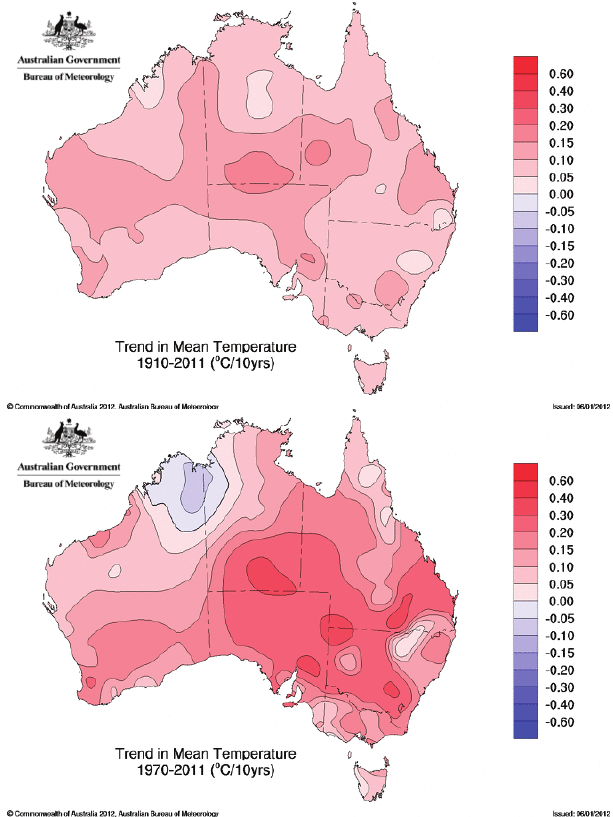
Figure 1. Australian Government Bureau of Meteorol- ogy. Australian climate variability & change Trend maps (from